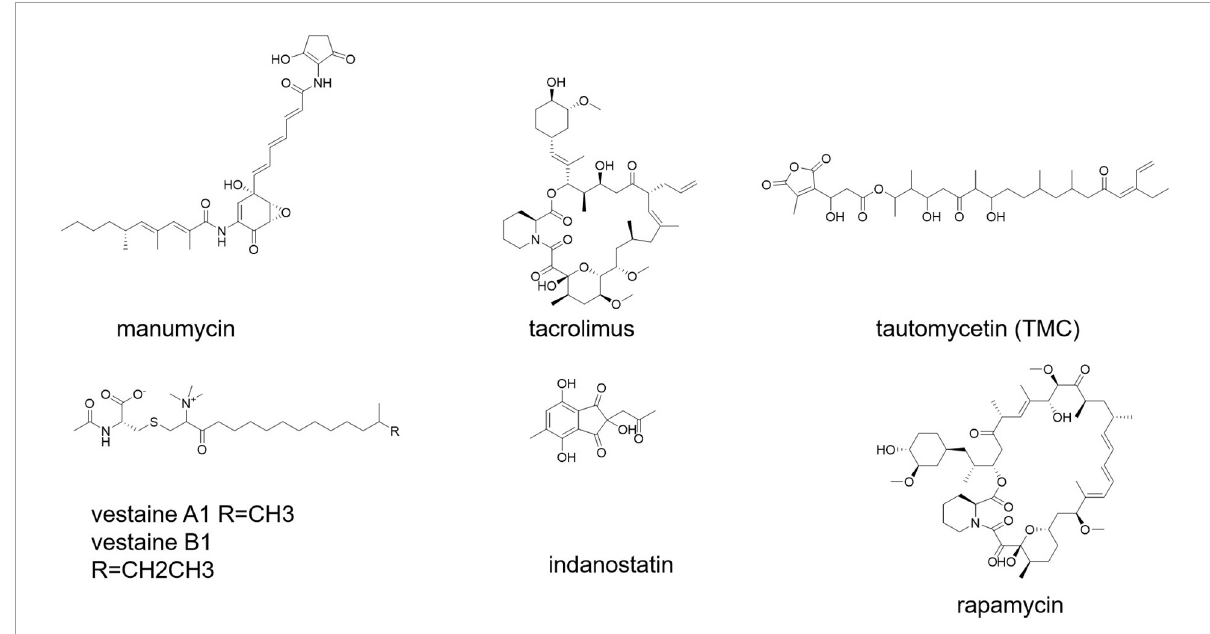
FIGURE6 Immunostimulant, anti-immune suppressive and vasoactive compounds.